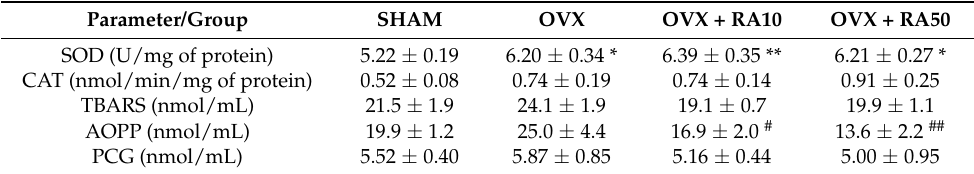
Table 1. Effect of rosmarinic acid on the serum activity of antioxidative enzymes and concentrations of oxidative damage markers in ovariectomized rats.